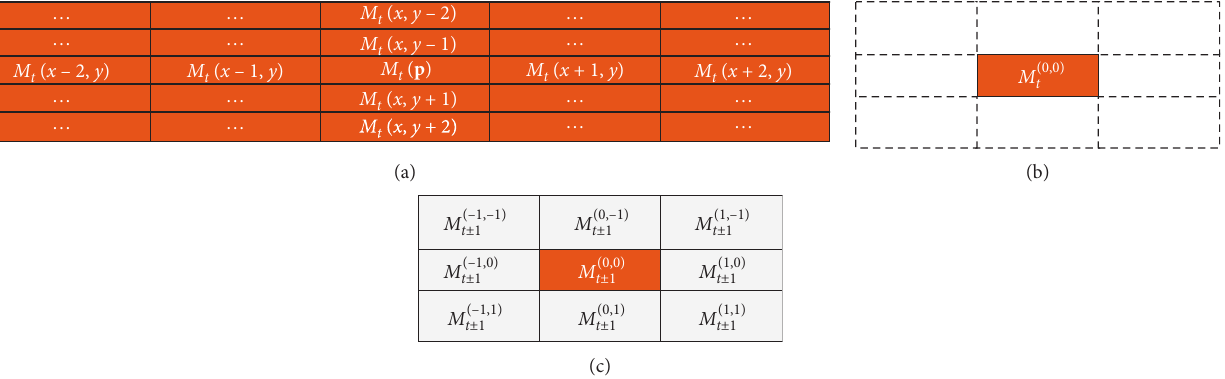
Figure 6: Representation notation of patches in the proposed method: (a) 5 × 5 patch centred at point p at the top-left corner of the current frame, (b) corresponding patch in the current frame, and (c) corresponding eighteen patches in the previous and next frames. Here, the patches outside of the frame boundary are considered the same as their nearest neighbour inside of